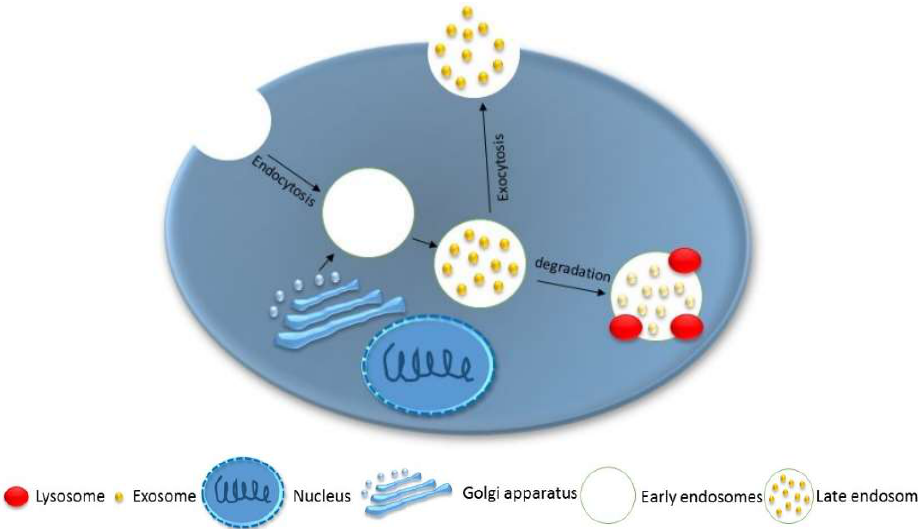
Figure 2. Exosome biogenesis in mammalian cells.